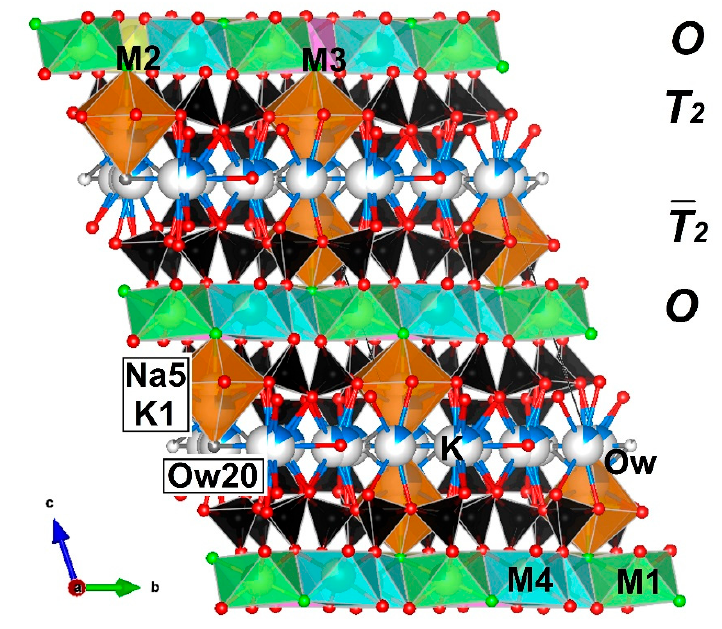
Figure 7. Crystal structure of fedorite (sample Yak-5) projected along the a axis. Oxygen and fluorine atoms are drawn in red and green, respectively. Si-tetrahedra are black. M1 (Na1Ca1)—light green, M2 (Ca2Na2)—yellow, M3 (Ca3Na3)—lilac, M4 (Ca4Na4)—cyan octahedra, Na5 polyhedra are shown (orange). Interlayer potassium atoms are designated as blue spheres. Ow atoms (oxygen of H 2 O molecule) are drawn in grey. The partially white coloring of the spheres indicates a vacancy. The figure shows the linkages between the O and T 2 sheets, T 2 and T 2 sheets.